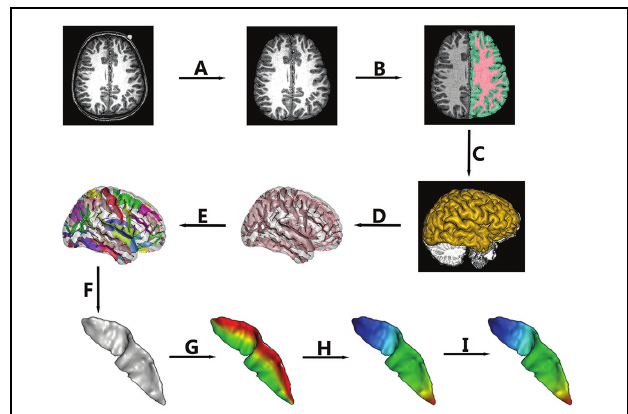
FIGURE 1 | The pipeline of central sulcus (CS) extraction and parameterization. Extraction of CS consisted of the following steps: (A) Skull stripping; (B) Spatial normalization, RF homogeneity correction, and tissue segmentation; (C) Extraction of gray matter (GM)/cerebrospinal fluid (CSF) surfaces; (D) Extraction of sulcal folds; (E) Automated labeling of sulci; (F) Manual verification of the CS. Sulcal parameterization included three steps: (G) Parameterization along the x coordinate; (H) Parameterization along the y coordinate; (I) Reparameterization by rescaling the y